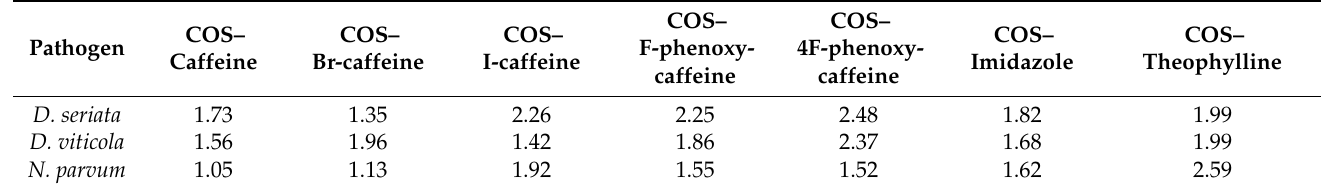
Table 7. Synergy factors for EC 90 concentrations (according to Wadley’s method) for conjugated complexes of chitosan oligomers with caffeine-derivatives, imidazole, and